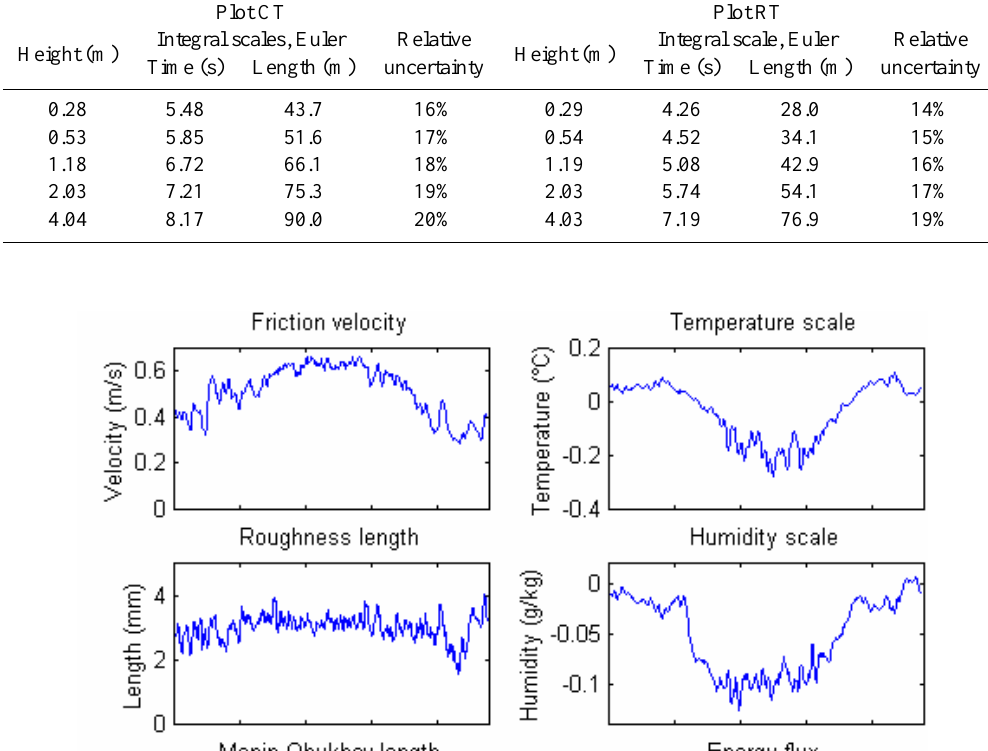
Figure 4: Variation of the horizontal wind variance with height (Plot CT, 25 July 1997) 30